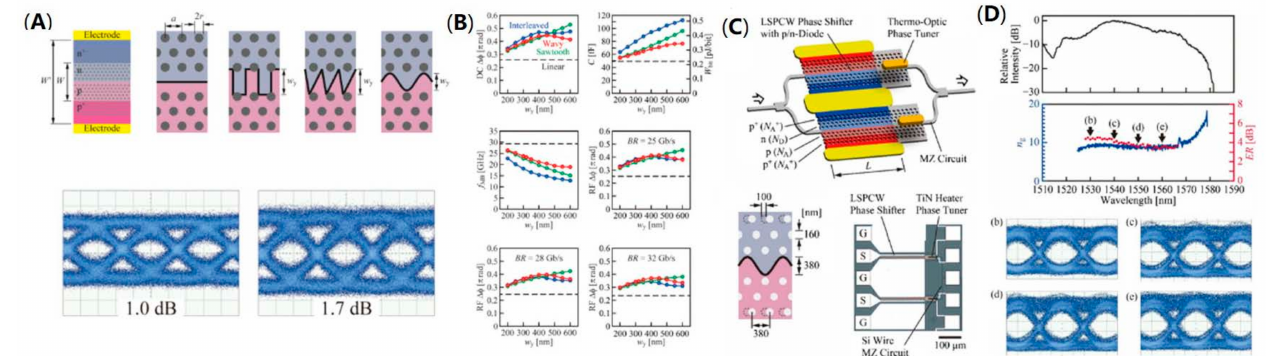
Figure 7. Optimized PN junctions and full C-band silicon photonic crystal modulator. ( A ) Structure of different PN junction profiles and 32 Gb/s eye diagram for wavy junction modulator [47]. ( B ) The performance comparison of four different profile junctions [47]. ( C ) The scheme and optical image of full C-band modulator [48]. ( D ) Transmission spectra, group index spectra, and 25 Gb/s eye diagrams at different wavelengths